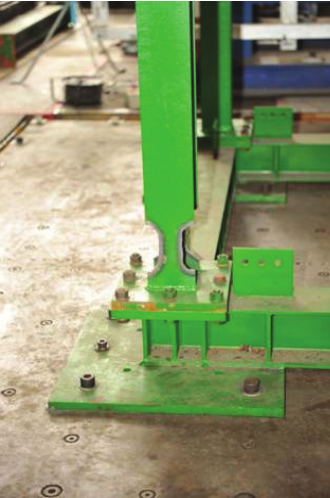
Figure 7: Flange partially cut out near the bottom of